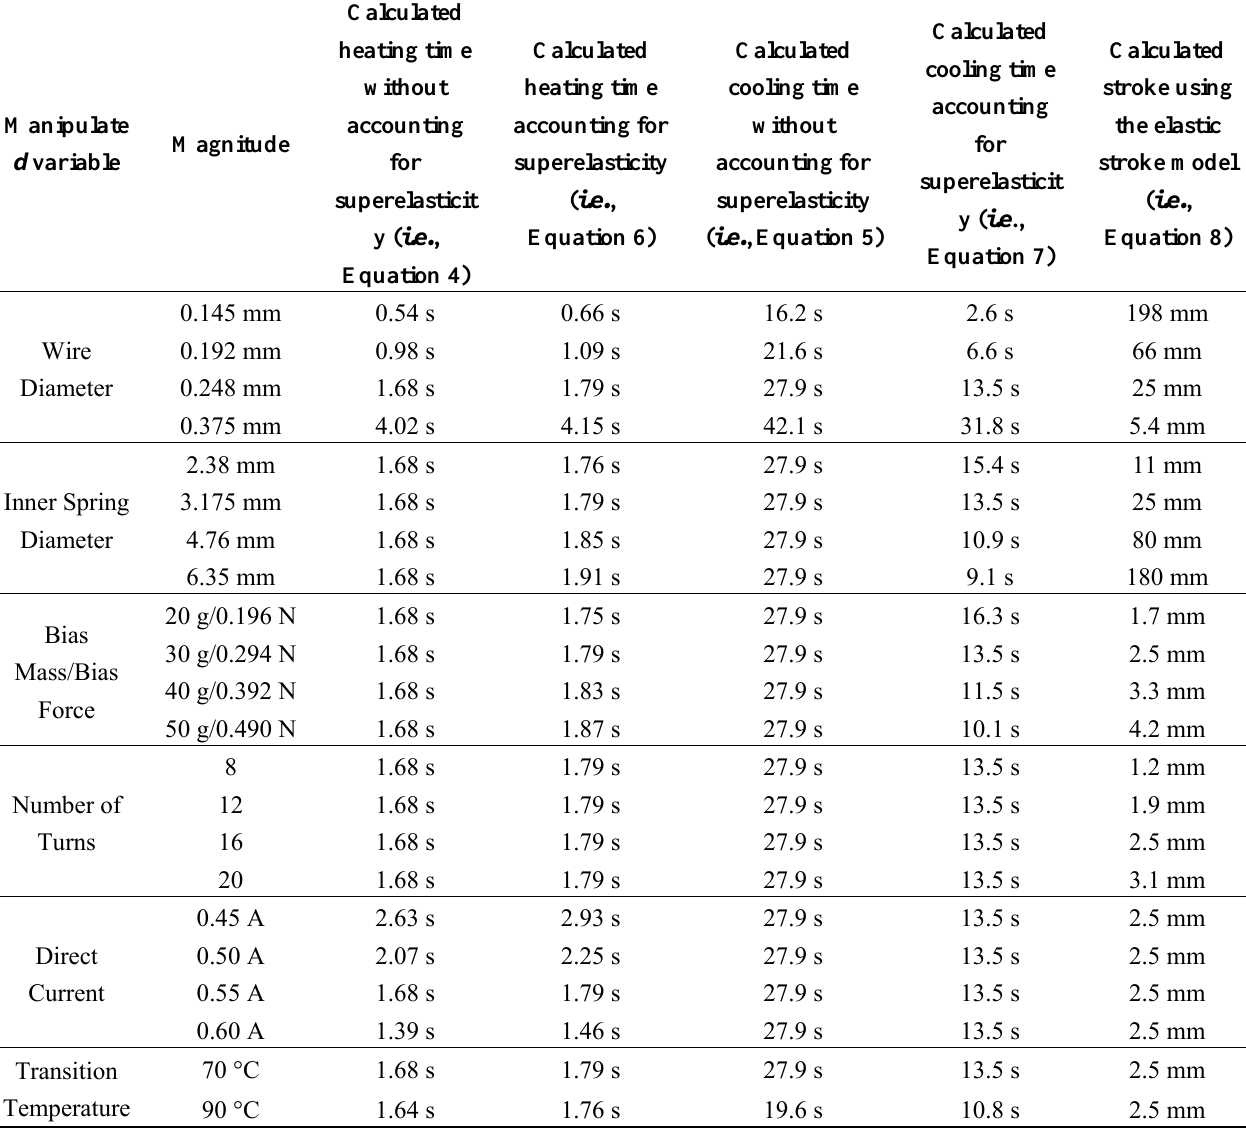
Table 3. Calculated values using Equations